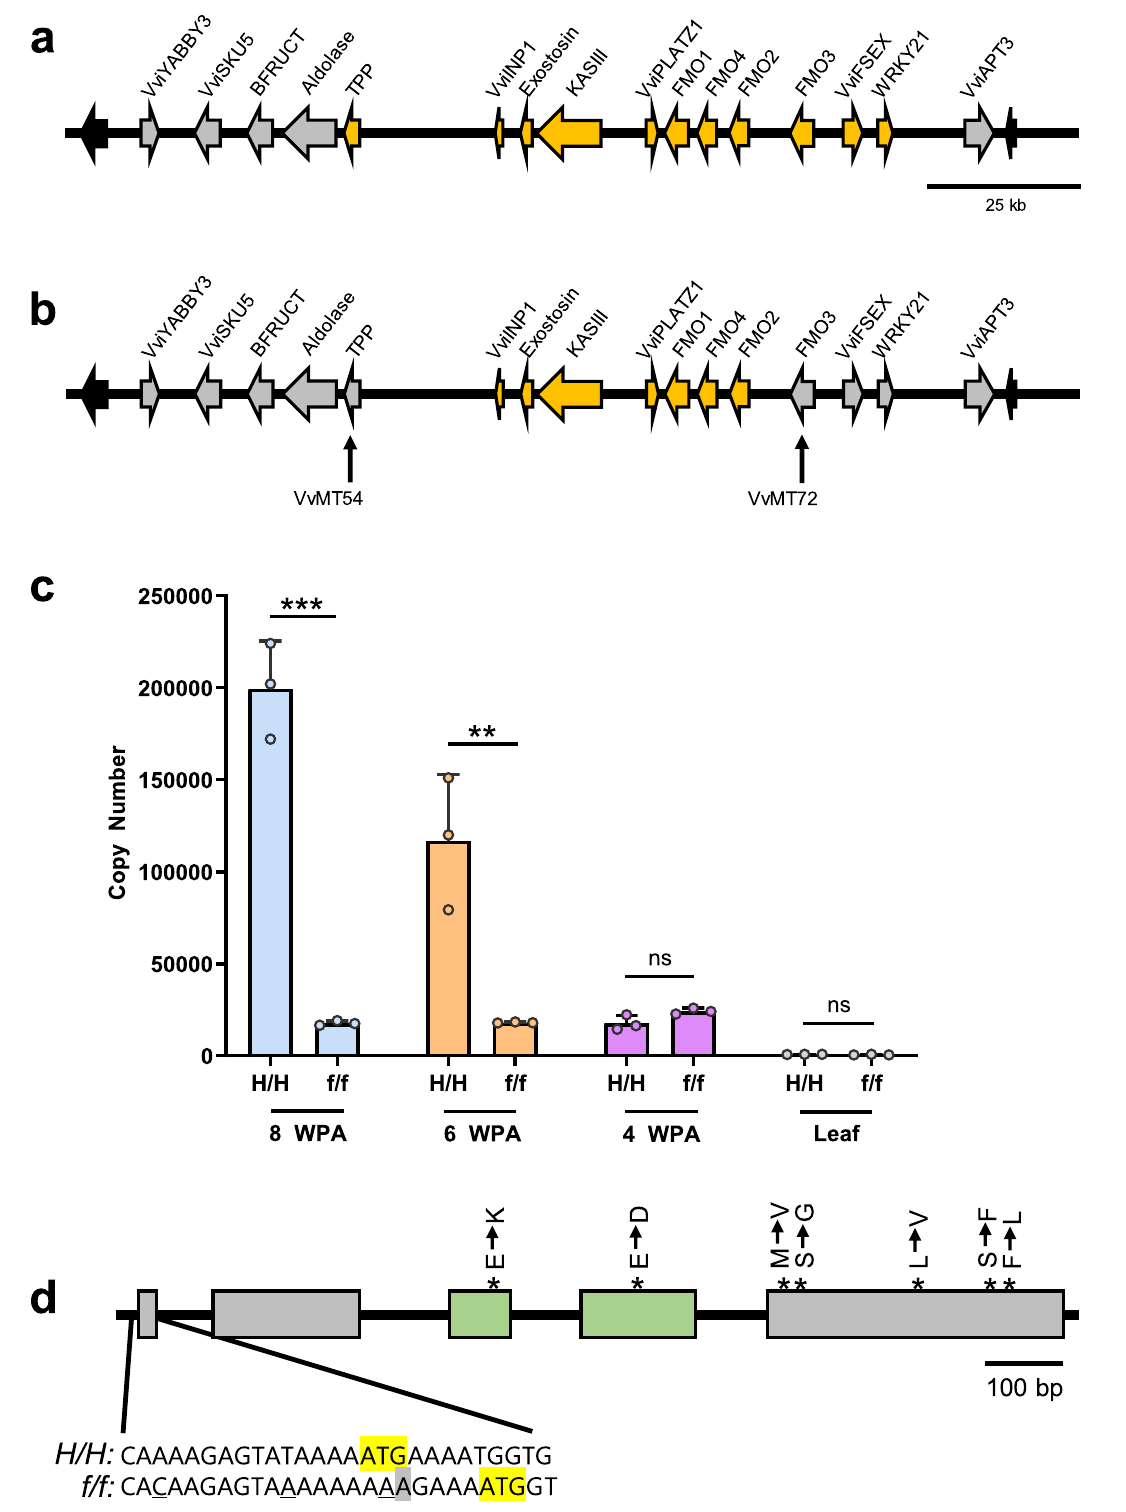
The recessive mutation resulting in the formation of re fl ex candidate gene required for stamen development. Of the